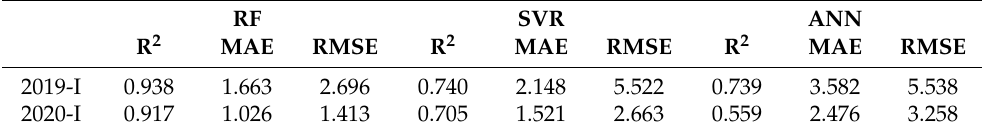
Table 3. Modeling set the precision of estimated PM 2.5 concentrations.